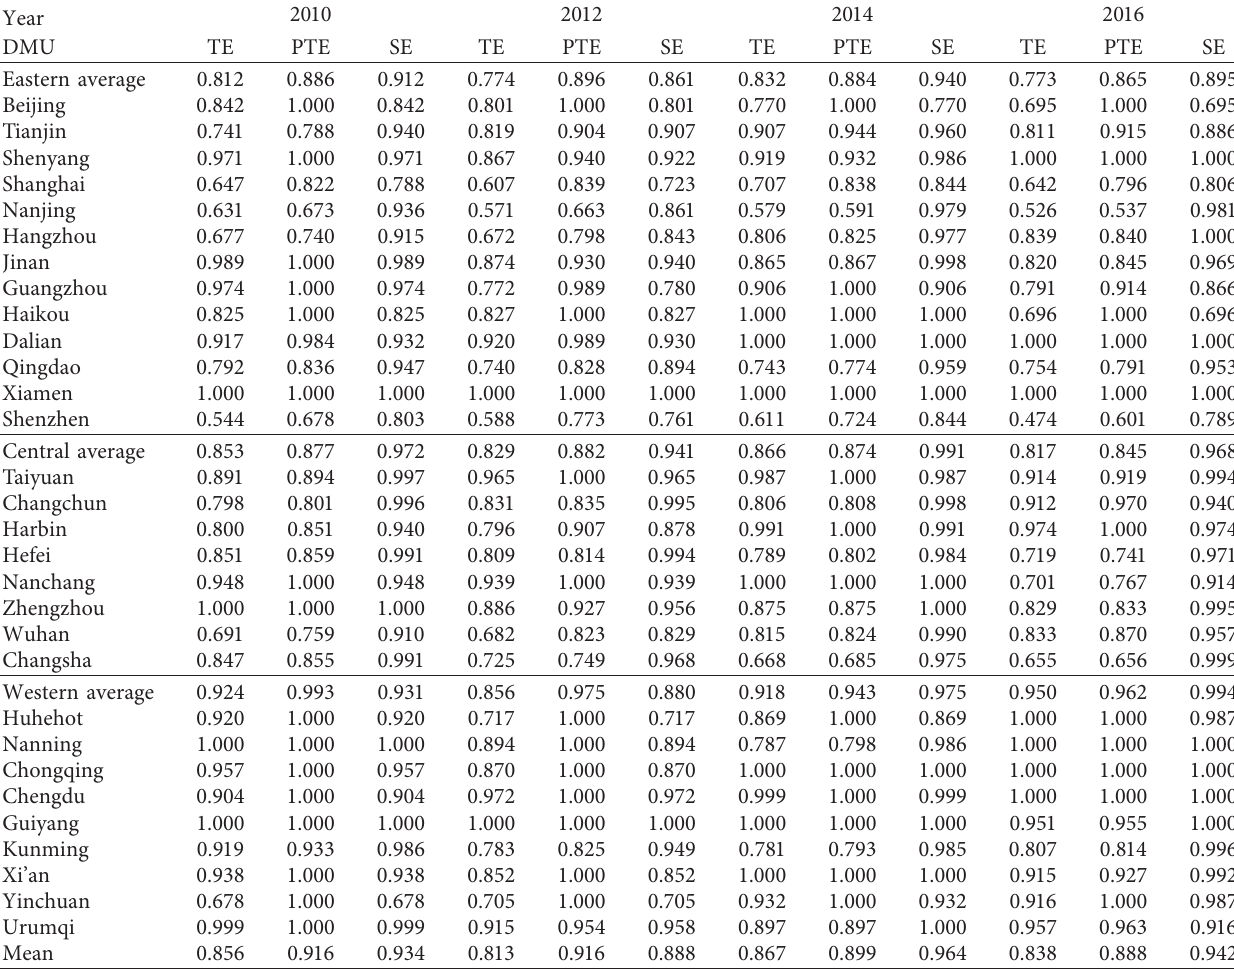
Table 3: Bus transport operation efficiency of 30 central cities in China, 2010–2016.